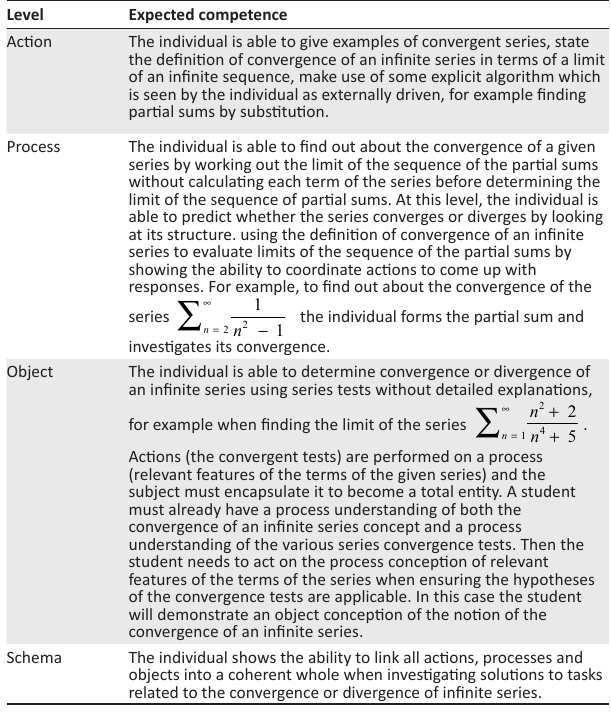
TABLE 1: Preliminary genetic decomposition of the limit of a